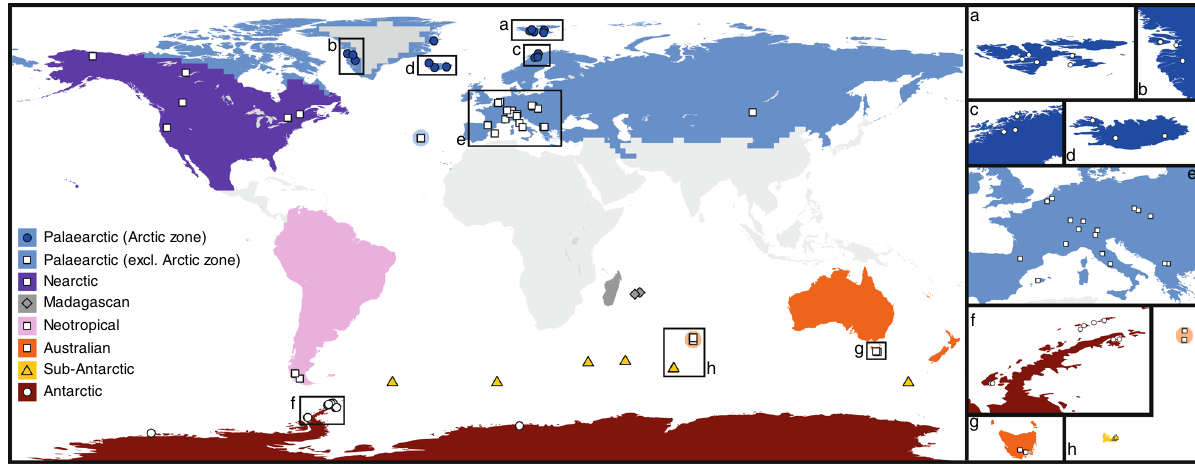
Fig. 1 Map showing the 207 sampling locations for P. borealis culture material. a – h show views of selected areas. Each individual symbol represents a sampling locality from which P. borealis cultures were established. Each symbol can comprise multiple individual samples. The different colors indicate eight major biogeographic regions that were based on ref. 72 , in addition to the Arctic, Antarctic and Sub-Antarctic regions. These regions were used in the analysis on the historical biogeography of P. borealis . Samples of Amsterdam and Saint Paul Island (orange circle, h ) were included in the same region as Tasmania (Australian zone), because they share the same climate in the Köppen-Geiger climate classi fi cation (code Cfb — temperate oceanic